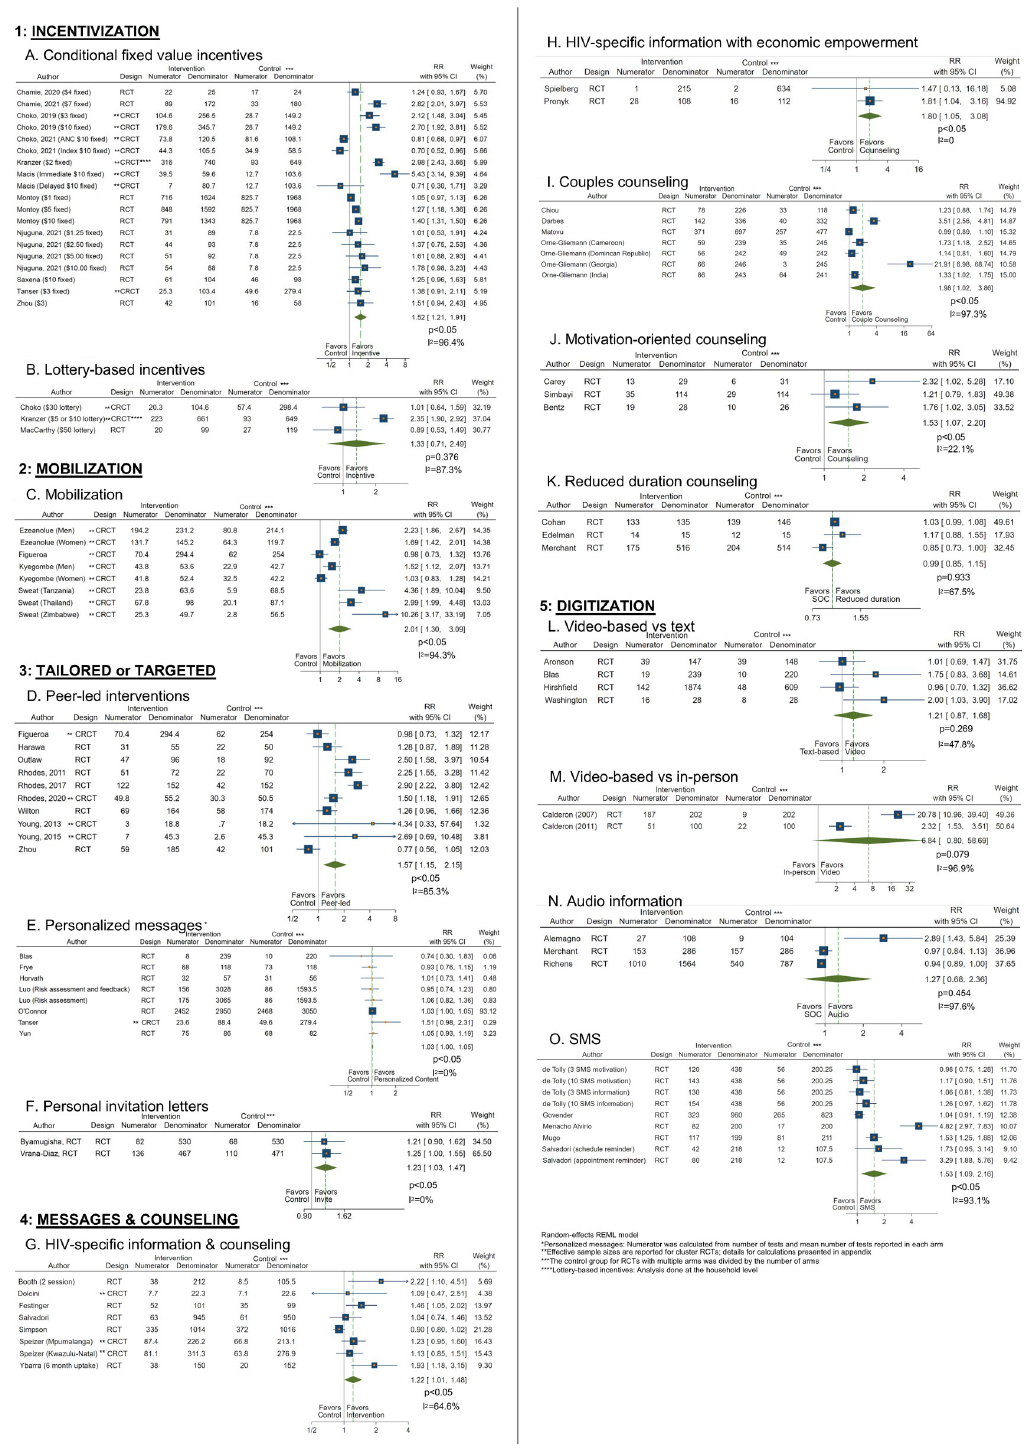
Fig 4. Meta-analysis plots of HTS uptake in relative and absolute differences. Panels (A–O) 1: INCENTIVES: (A) conditional fixed value incentives, (B) lottery-based incentives, 2: MOBILIZATION: (C) mobilization, 3: TAILORED or TARGETED: (D) peer-led interventions, (E) personalized messages, (F) personal invitation letters, 4: MESSAGES & COUNSELING: (G) HIV- specific information and counseling, (H) HIV-specific information with economic empowerment, (I) couples counseling, (J) motivation-oriented counseling, (K) reduced duration counseling, 5: DIGITIZATION: (L) video-based vs text, (M) video-based